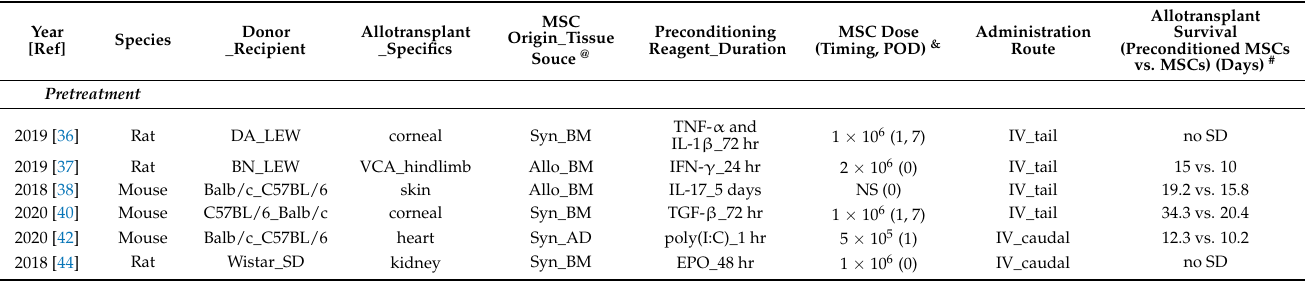
Table 1. Summary of preconditioned MSCs applied in organ/tissue